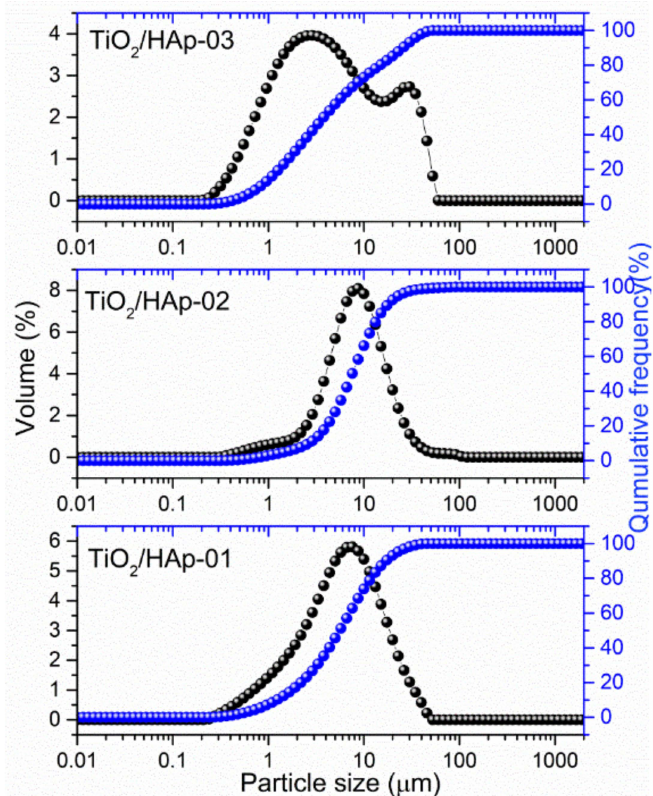
Figure 3. PSD distribution in TiO 2 /Hap-01, TiO 2 /Hap-02, and TiO 2 /HAp-03 samples. A measured value of the plan range , which was below three for TiO 2 /HAp-01 and TiO 2 /HAp-02, indicated a relatively narrow distribution. The third sample’s span was much higher, pointing to a broader